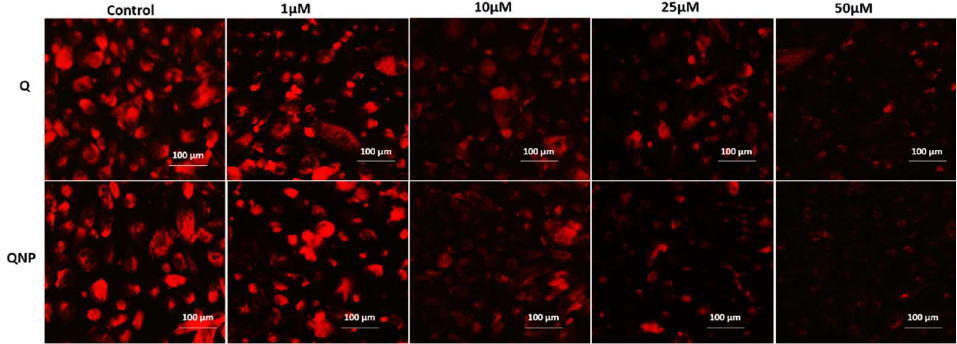
Figure 6. Fluorescence micrographs of EB/AO double stained HeLa cell line treated with different concentrations of Q or QNPs for 48 h. Apoptotic (light orange) and necrotic (dark orange) cells are indicated by arrows.